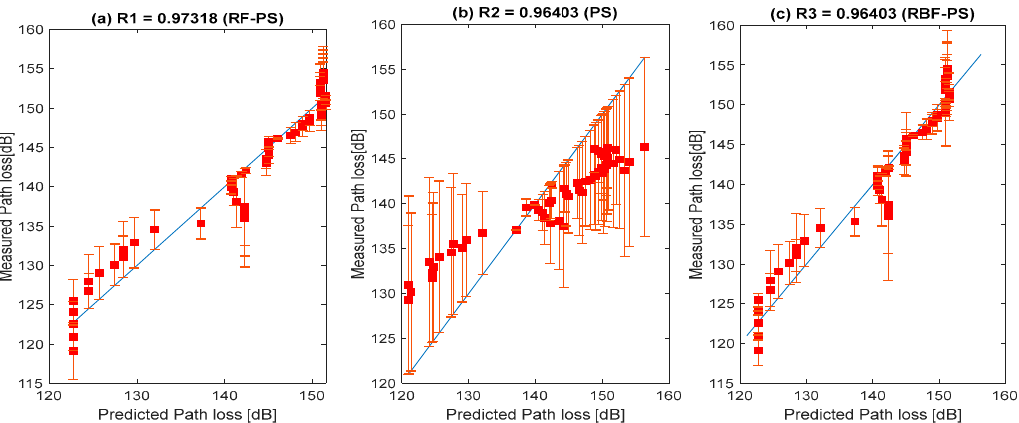
Figure 26. Results showing the correlation between the measured path loss and predicted path loss using the hybrid RF-PS prediction method and two existing standard path loss prediction methods in site 1 of location 3.